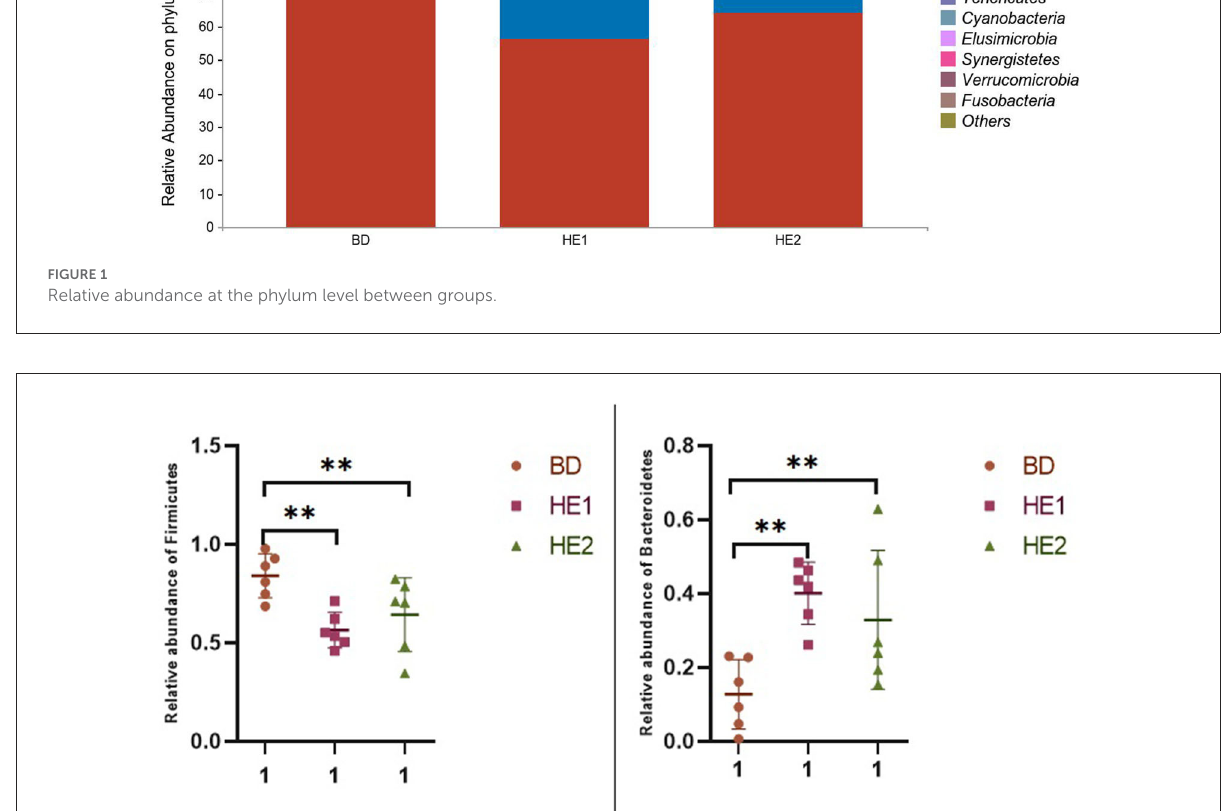
FIGURE2 Scatter plot of the relative abundance of significantly different phylum in each